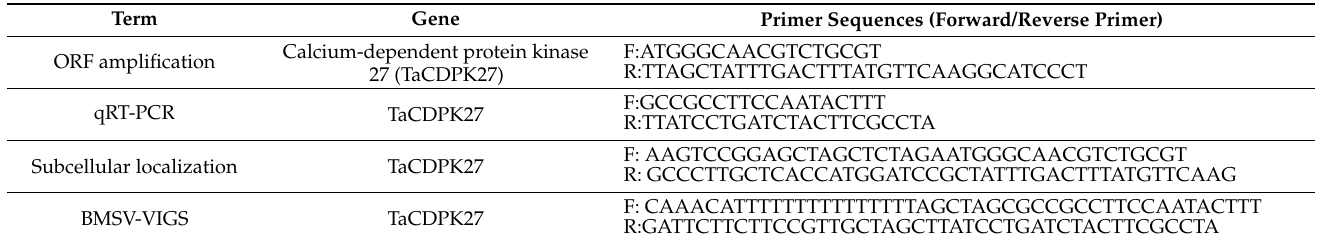
Table 3. Primers used in this